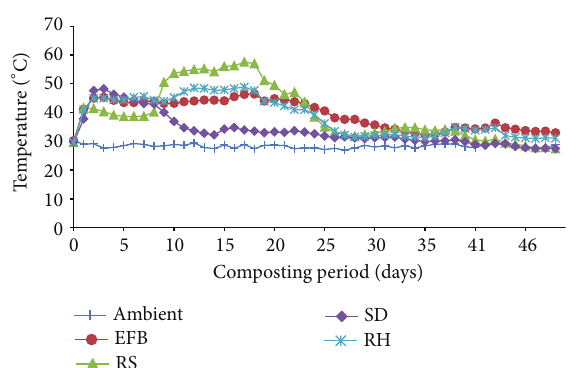
Figure 1: Composts and ambient temperature with time of selected